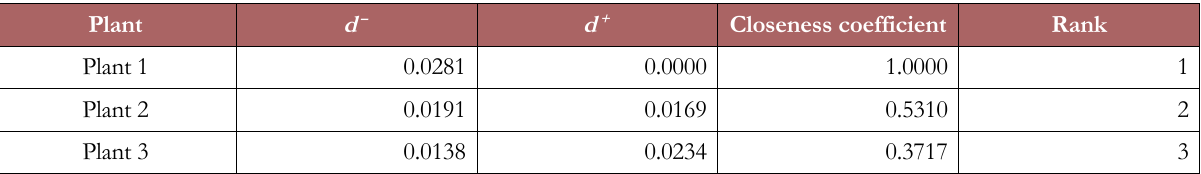
Table 2. Distance, closeness coefficient and the rank of each plant (the nine